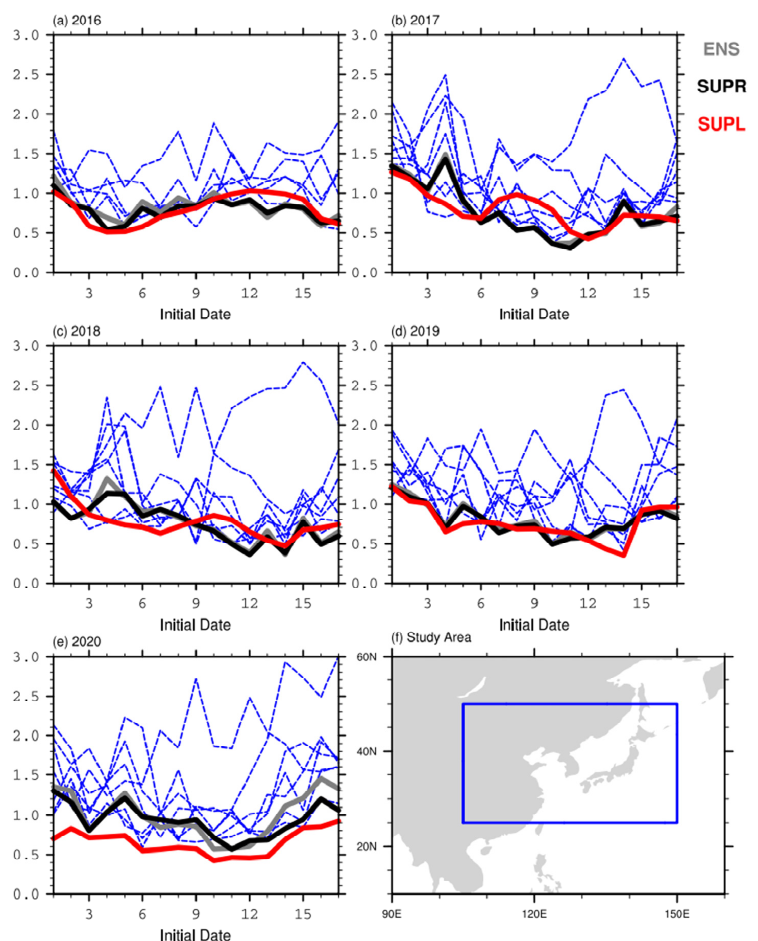
Figure 1. Variation in the root-mean-square error (RMSE) at the initial 1–17 days, derived from seven models (blue lines) and the ensemble forecasts of ENS (grey line), SUPR (black line), and SUPL (red line) in ( a ) 2016, ( b ) 2017, ( c ) 2018, ( d ) 2019, and ( e ) 2020. The blue box in ( f ) represents the study